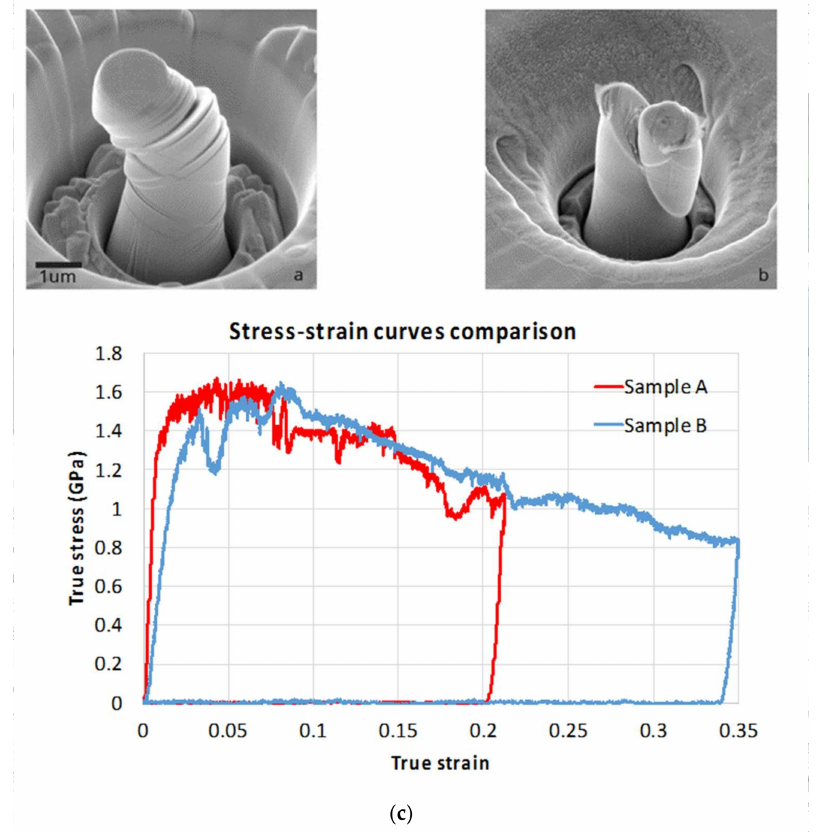
Figure 6. Comparison of two similar sized pillars ( a ) SEM image taken using SE of a 30 ◦ tilt 1.5 µ m pillar dominated by mutliple cross slip (see dark-light traces visible on the pillar front surface) during compression; ( b ) SEM image of a 30 ◦ tilt 1.41 µ m pillar dominated by large single slip during compression (same scale bar as Figure a); ( c ) corresponding true stress–true strain traces for the two